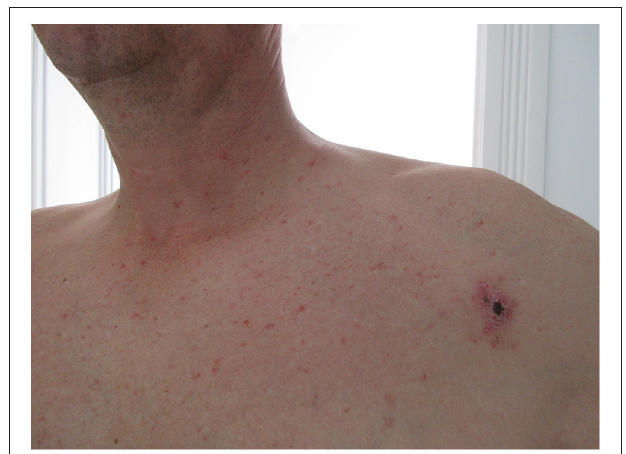
FIGURE 1 | Eschar of inoculation and Rash taken on the 15th day.